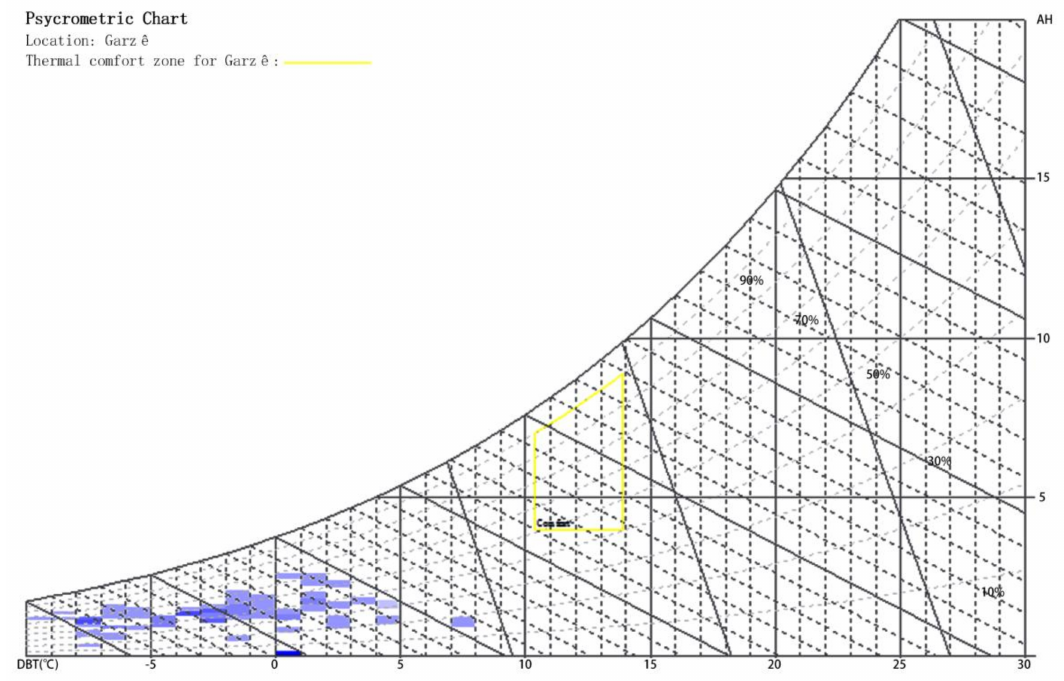
Figure 14. Thermal comfort zone for residential buildings in Danba during